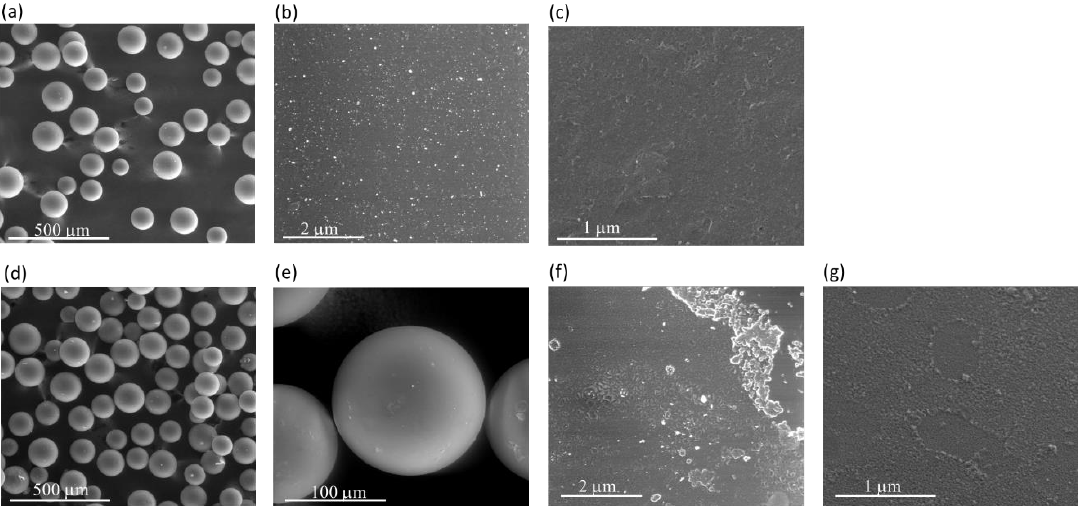
Figure 3. SEM micrographs of ( a ) starting MR (200×), ( b ) starting MR (40,000×), ( c ) starting MR (100,000×), ( d ) CAT-4-MR (200×), ( e ) CAT-4-MR (1000×), ( f ) CAT-4-MR (40,000×) and ( g ) CAT-4-MR (100,000×).